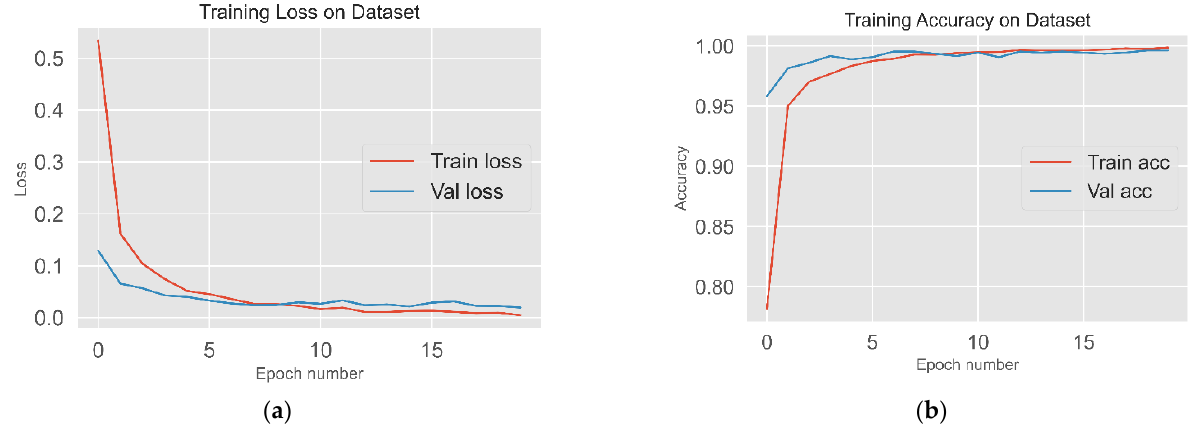
Figure 5. ( a ) Visualizing the loss reduction for the last fold cross-validation training process; ( b ) visualizing the accuracy for the last fold cross-validation training process. Train = training, Val = validation, acc = accuracy.